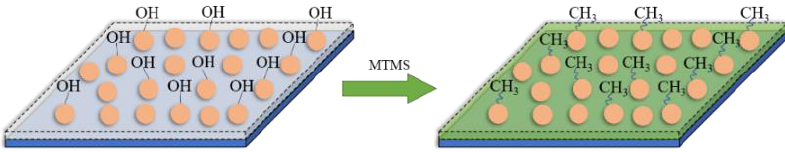
Figure 9. The modification of Nano SiO 2 and micron ZnO.